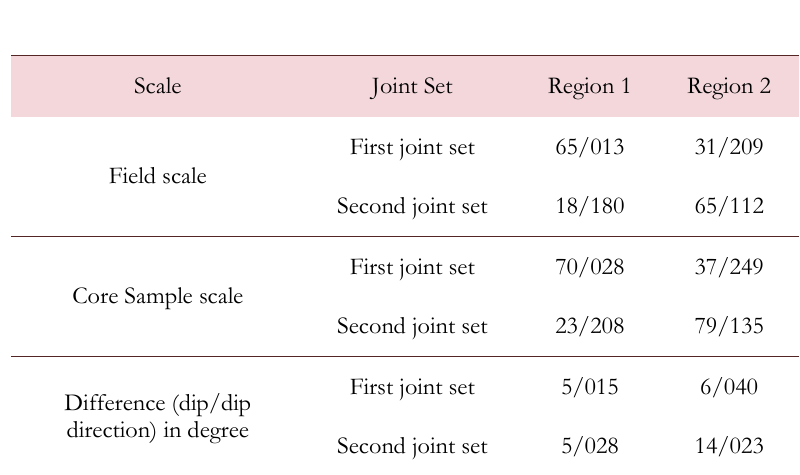
Figure 8: The number of micro-fractures of core samples for region 1 (the left diagram) and region 2 (the right diagram)